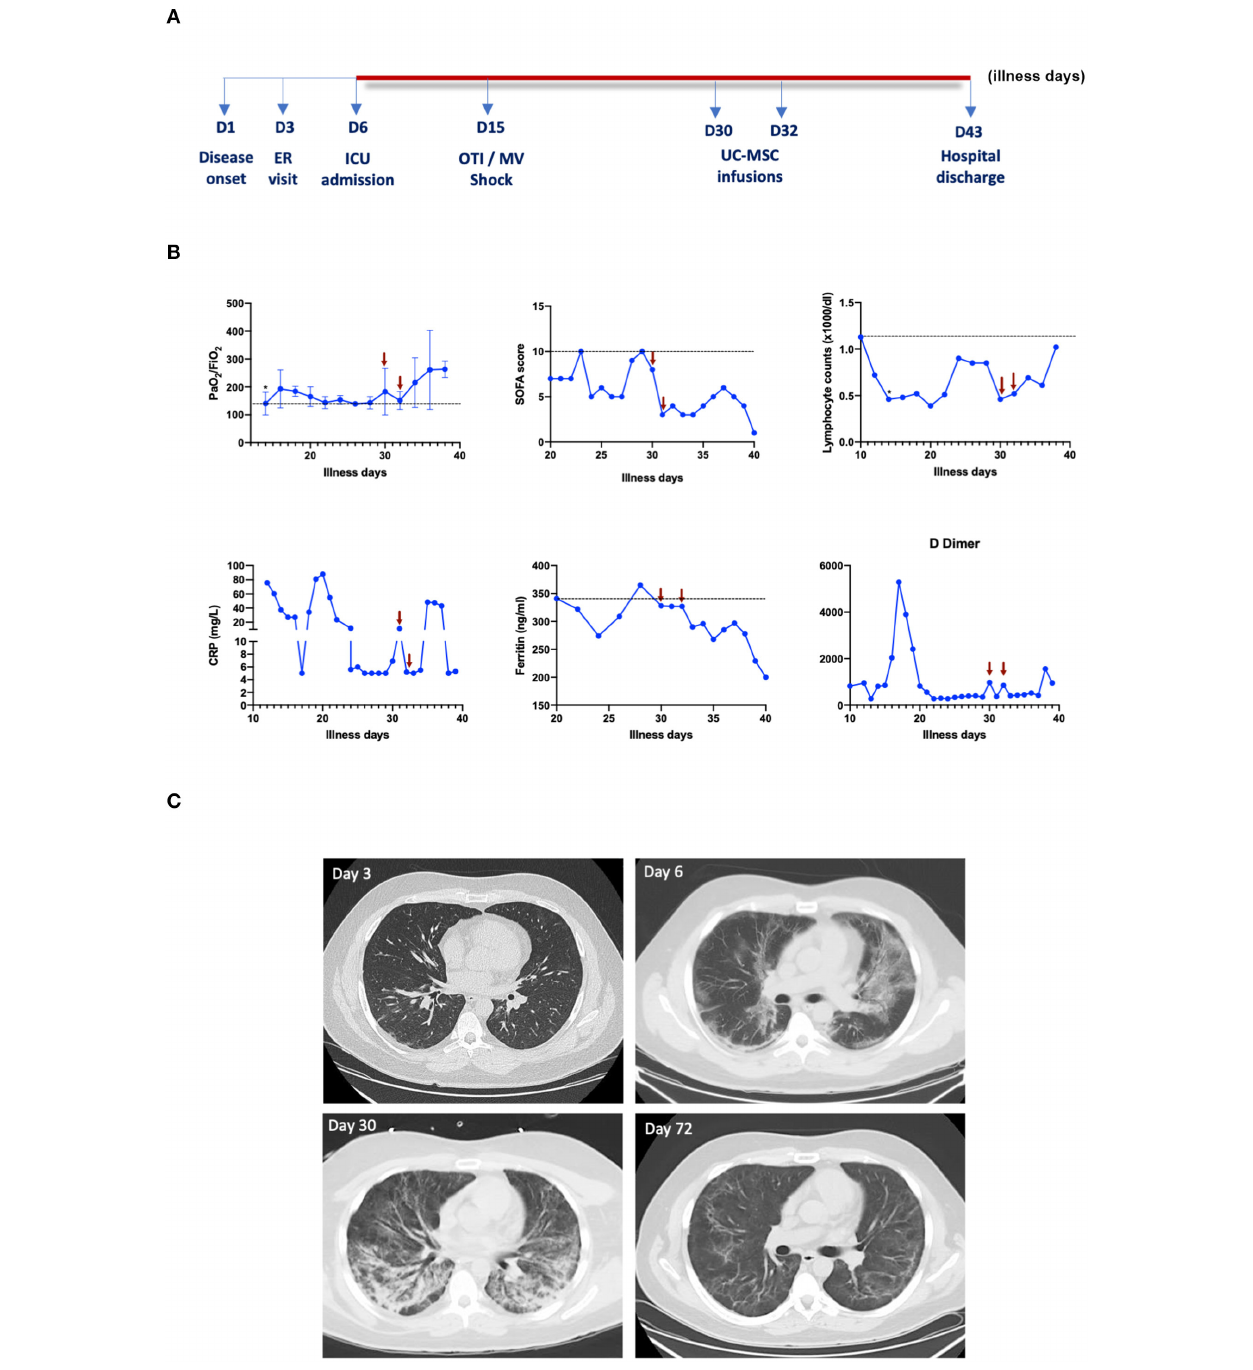
FIGURE 1 | Evolution of clinical, laboratory, and radiological parameters. (A) Timeline of the duration of patient stays in the intensive care unit (ICU), shown as illness days. OTI, orotracheal intubation; MV, mechanical ventilation; UC-MSC, umbilical cord-derived mesenchymal stromal cells. Arrows represent the time of MSC infusions; respective samples were collected prior to MSC infusion. *Day of orotracheal intubation. (B) Data are represented as single values or mean ± SD of the values of different measurements performed each day. (C) The representative images of chest CT scans were performed at different time points.